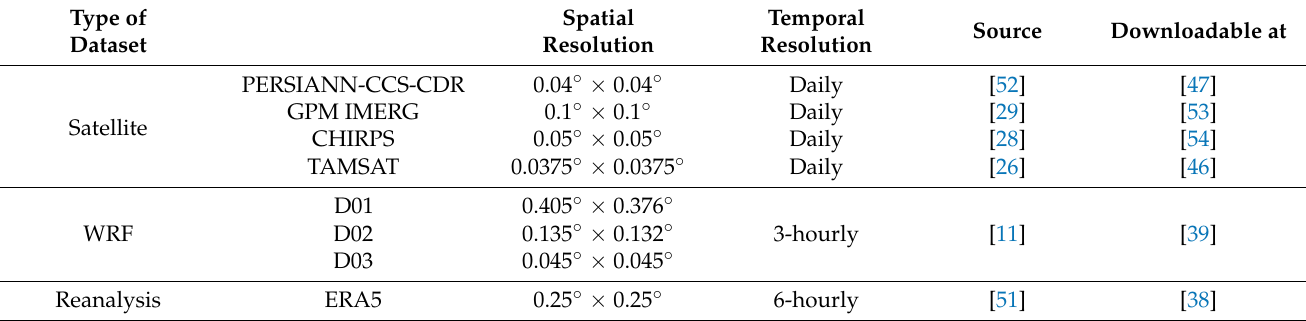
Table 2. List of gridded precipitation datasets used in this